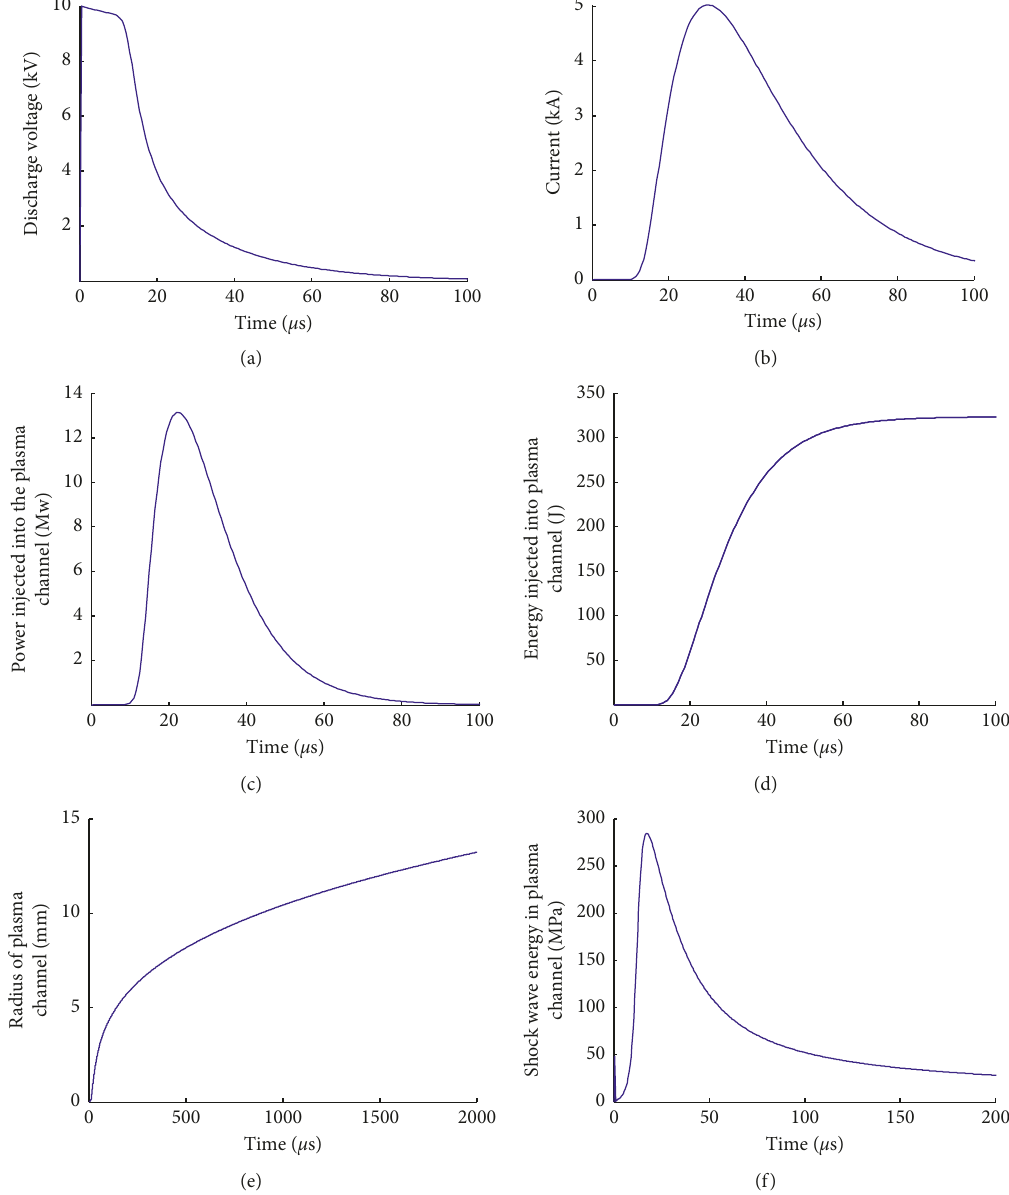
Figure 8: Plasma channel waveforms: (a) Voltage; (b) current; (c) power; (d) energy; (e) radius; and (f) shock